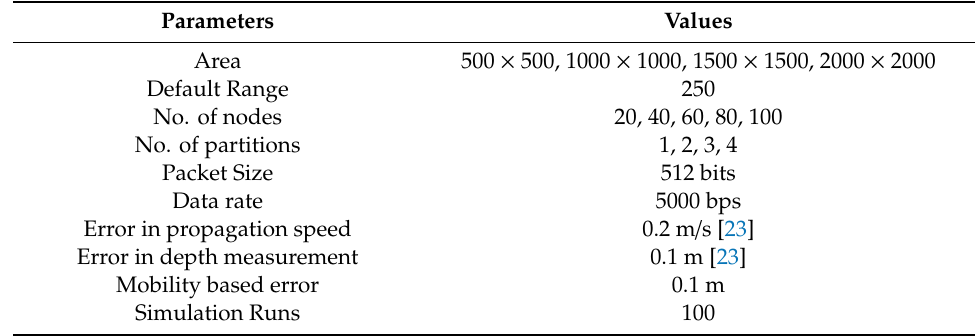
Table 4. Simulation parameters.